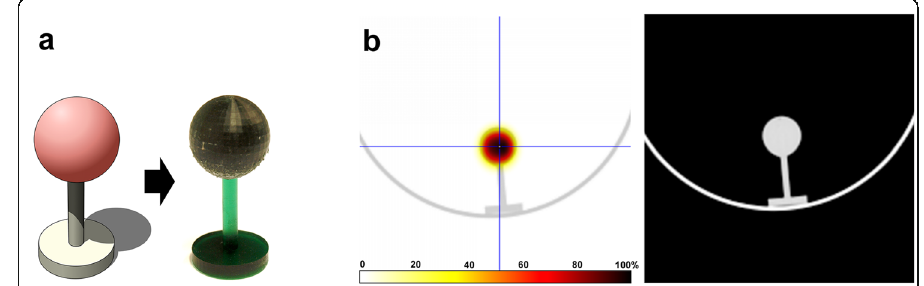
Fig. 4 Computer model and photo of the 3D printed spherical phantom ( a ) and the corresponding SPECT/ CT images of the radioactive phantom ( b ); note that the pedestal was printed with non-radioactive